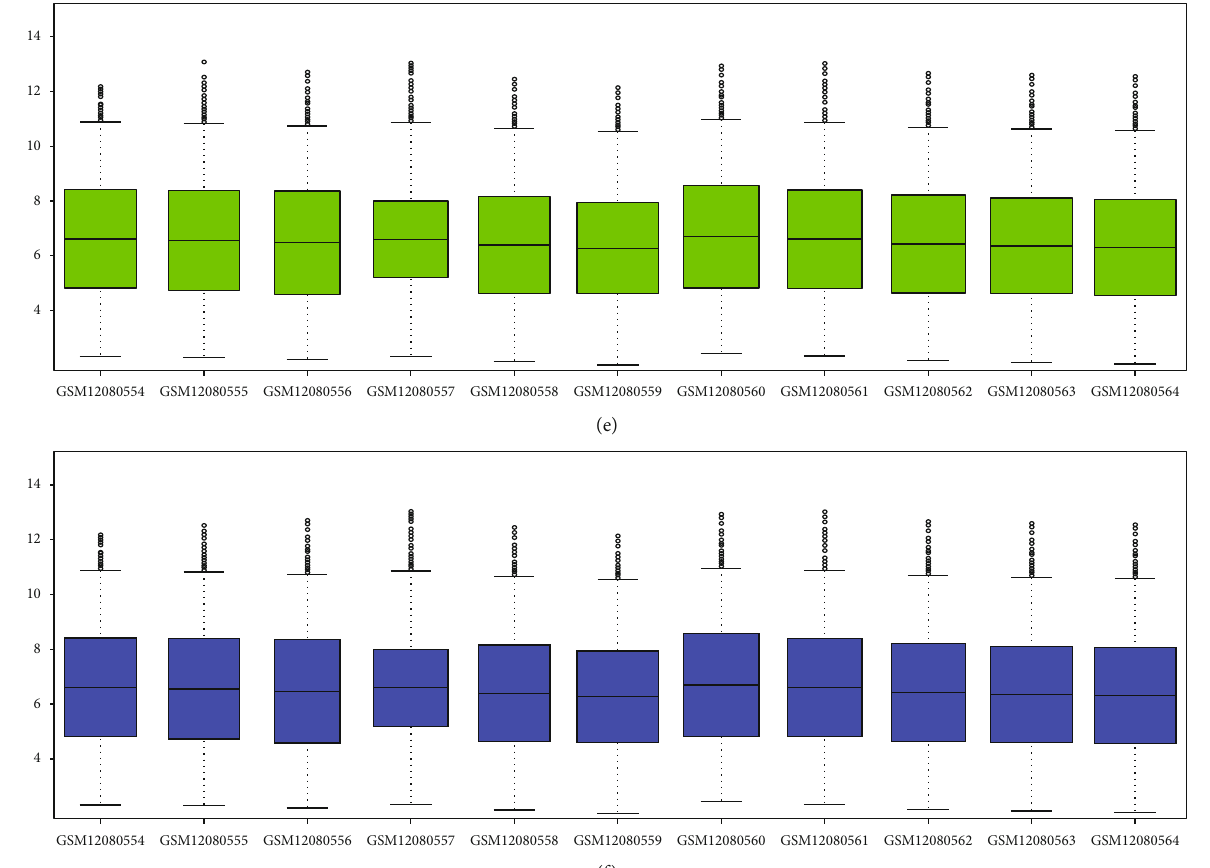
Figure 1: Heatmap of the DEGs between type 2 diabetes and normal people in GSE49566 and GSE78891: (a) heatmap clustering of the DEGs in GSE49566; (b) gene expression information of each sample before standardization in GSE49566; (c) gene expression information of each sample after standardization in GSE49566; (d) heatmap clustering of the DEGs in GSE78891; (e) gene expression information of each sample before standardization in GSE78891; (f) gene expression information of each sample after standardization in